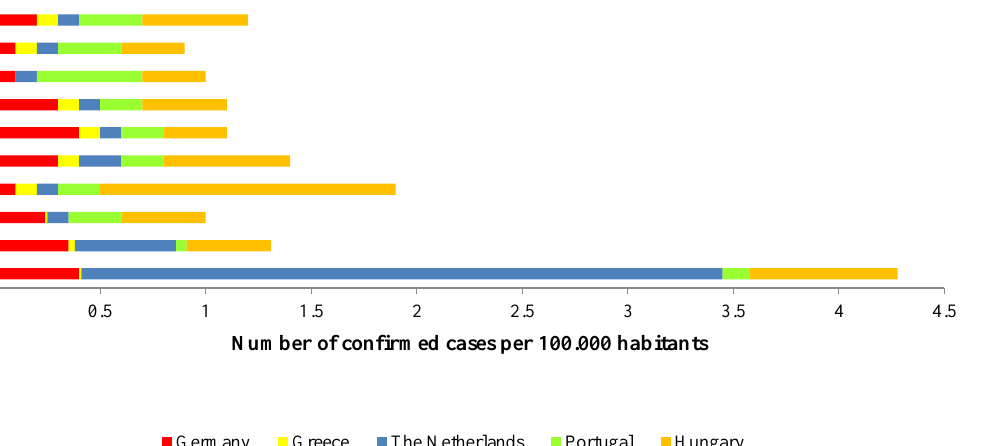
Figure 3. Rates of confirmed human cases of Q fever in four European Countries from 2010 to 2019 [148–150].